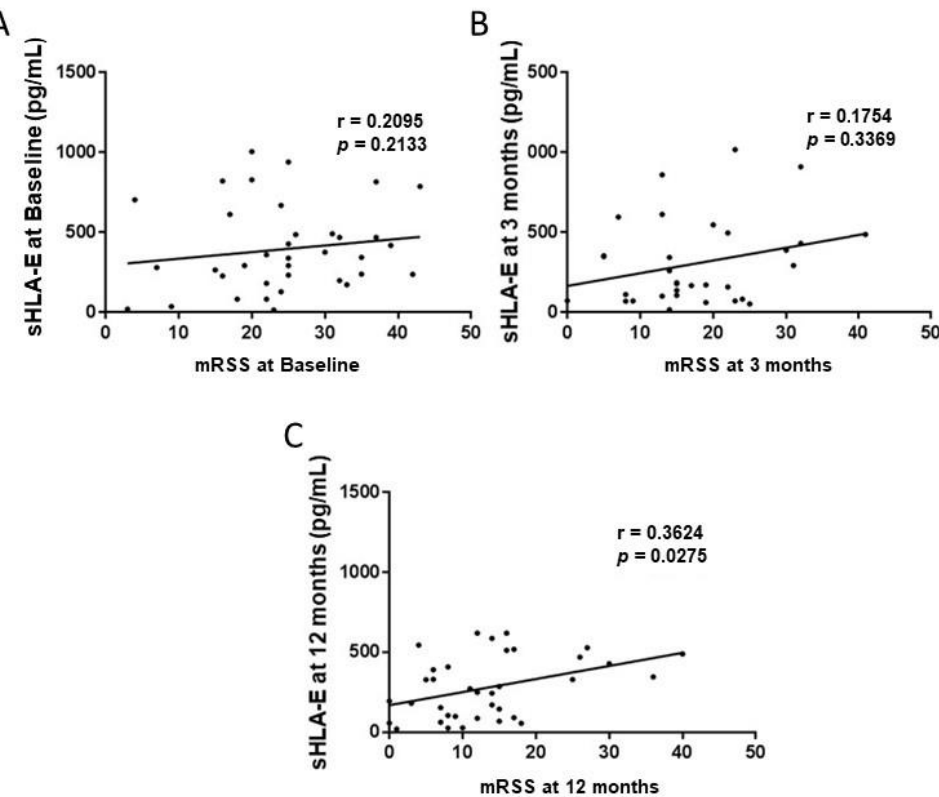
Figure 3. Correlation between the circulating levels of soluble HLA-G and HLA–E and Rodnan Skin Scores (mRSS) in Systemic Sclerosis patients before autologous hematopoietic stem cell transplan- tation (baseline) ( A ), and at 3- ( B ) and 12-month ( C ) follow-up.